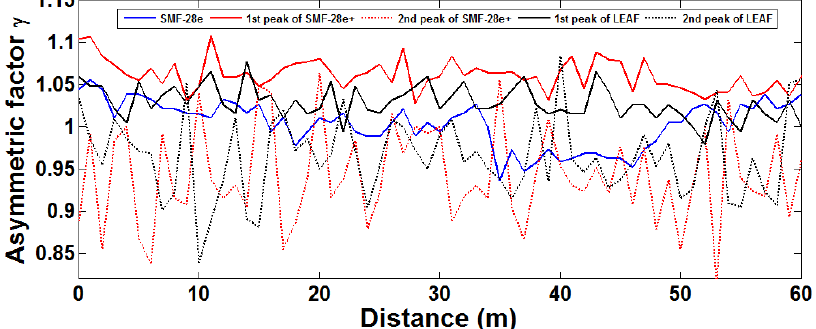
Figure 3. Asymmetric Brillouin spectrum property of SMF28e, SMF28e+ and LEAF vs .